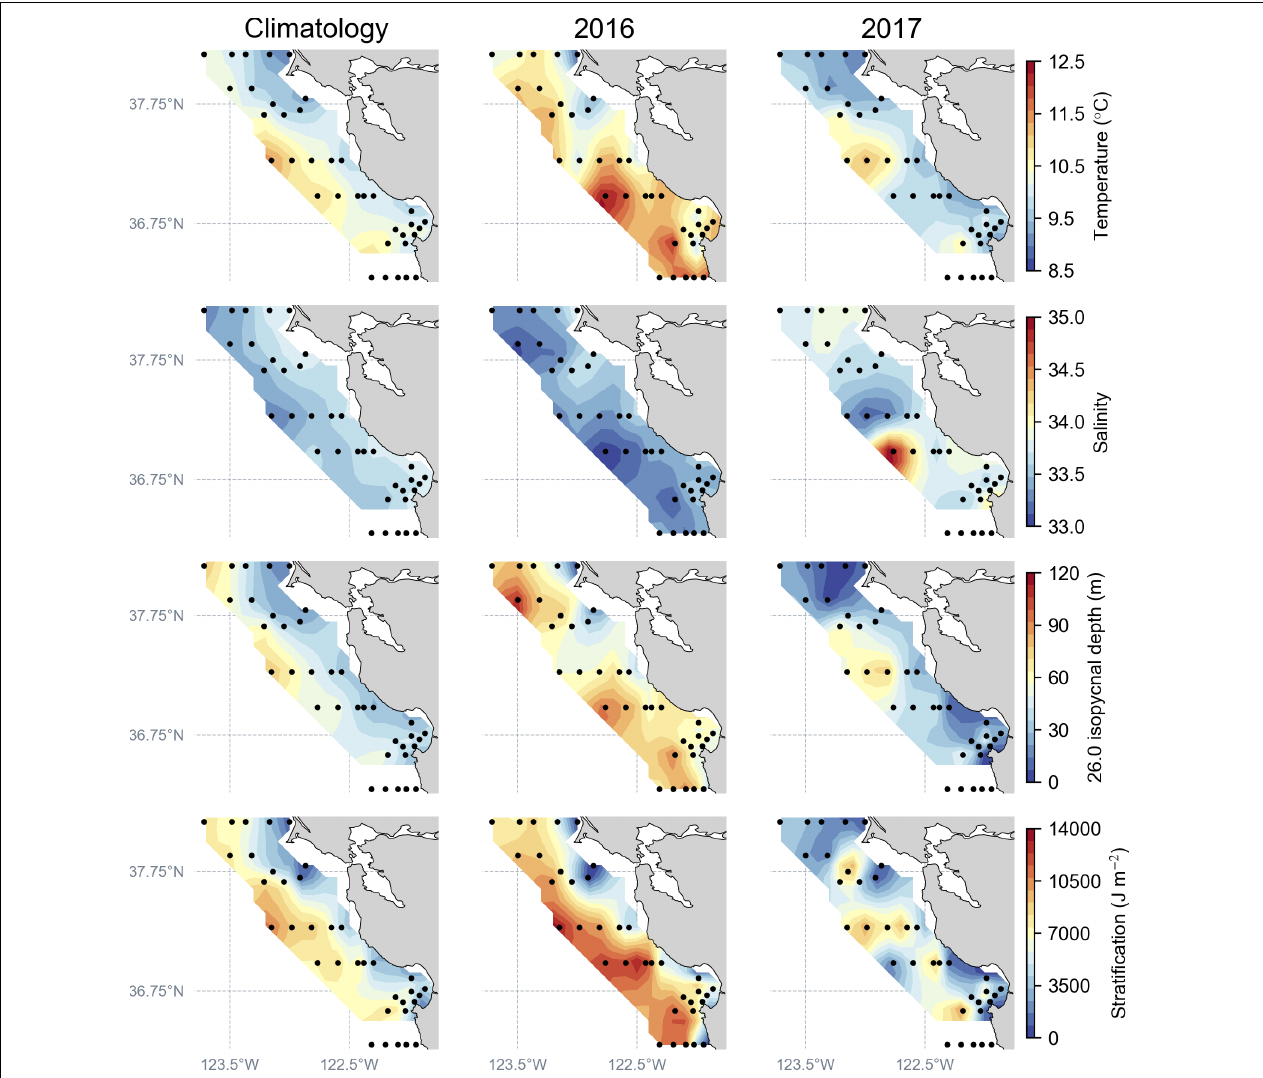
FIGURE 2 | Regional ocean conditions, determined by the full set of CTD sampling stations (black dots) during April–May, to construct the spatial mean climatology (1990–2017) compared to April–May 2016 and 2017. Ocean condition parameters plotted: temperature and salinity at 20–40 m depth, depth of the 26.0 isopycnal, and stratification